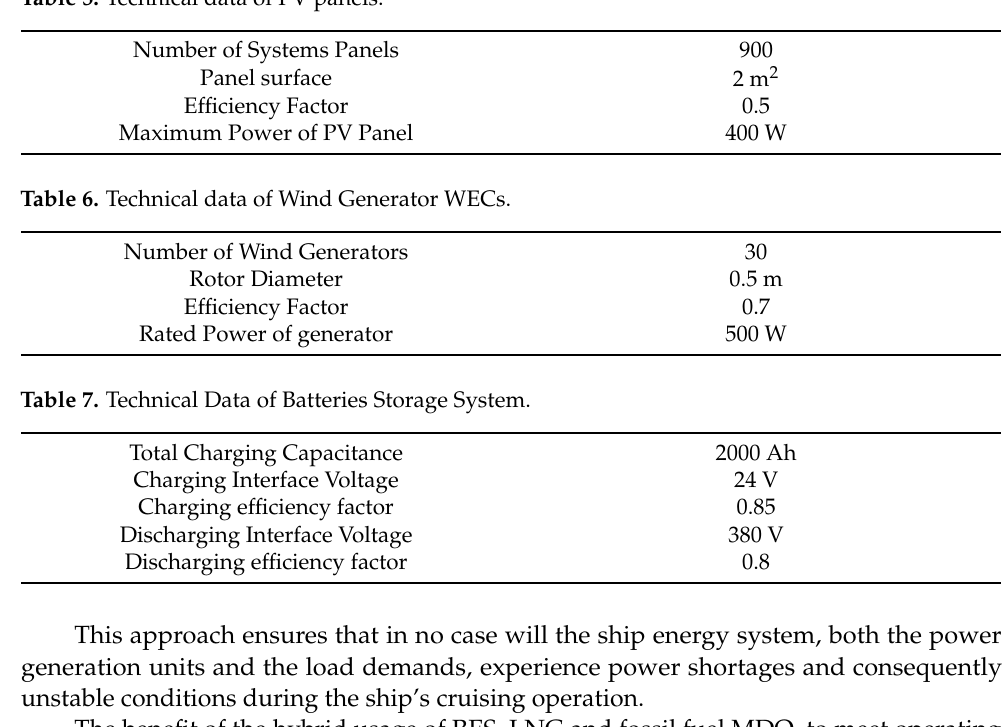
Table 5. Technical data of PV panels.